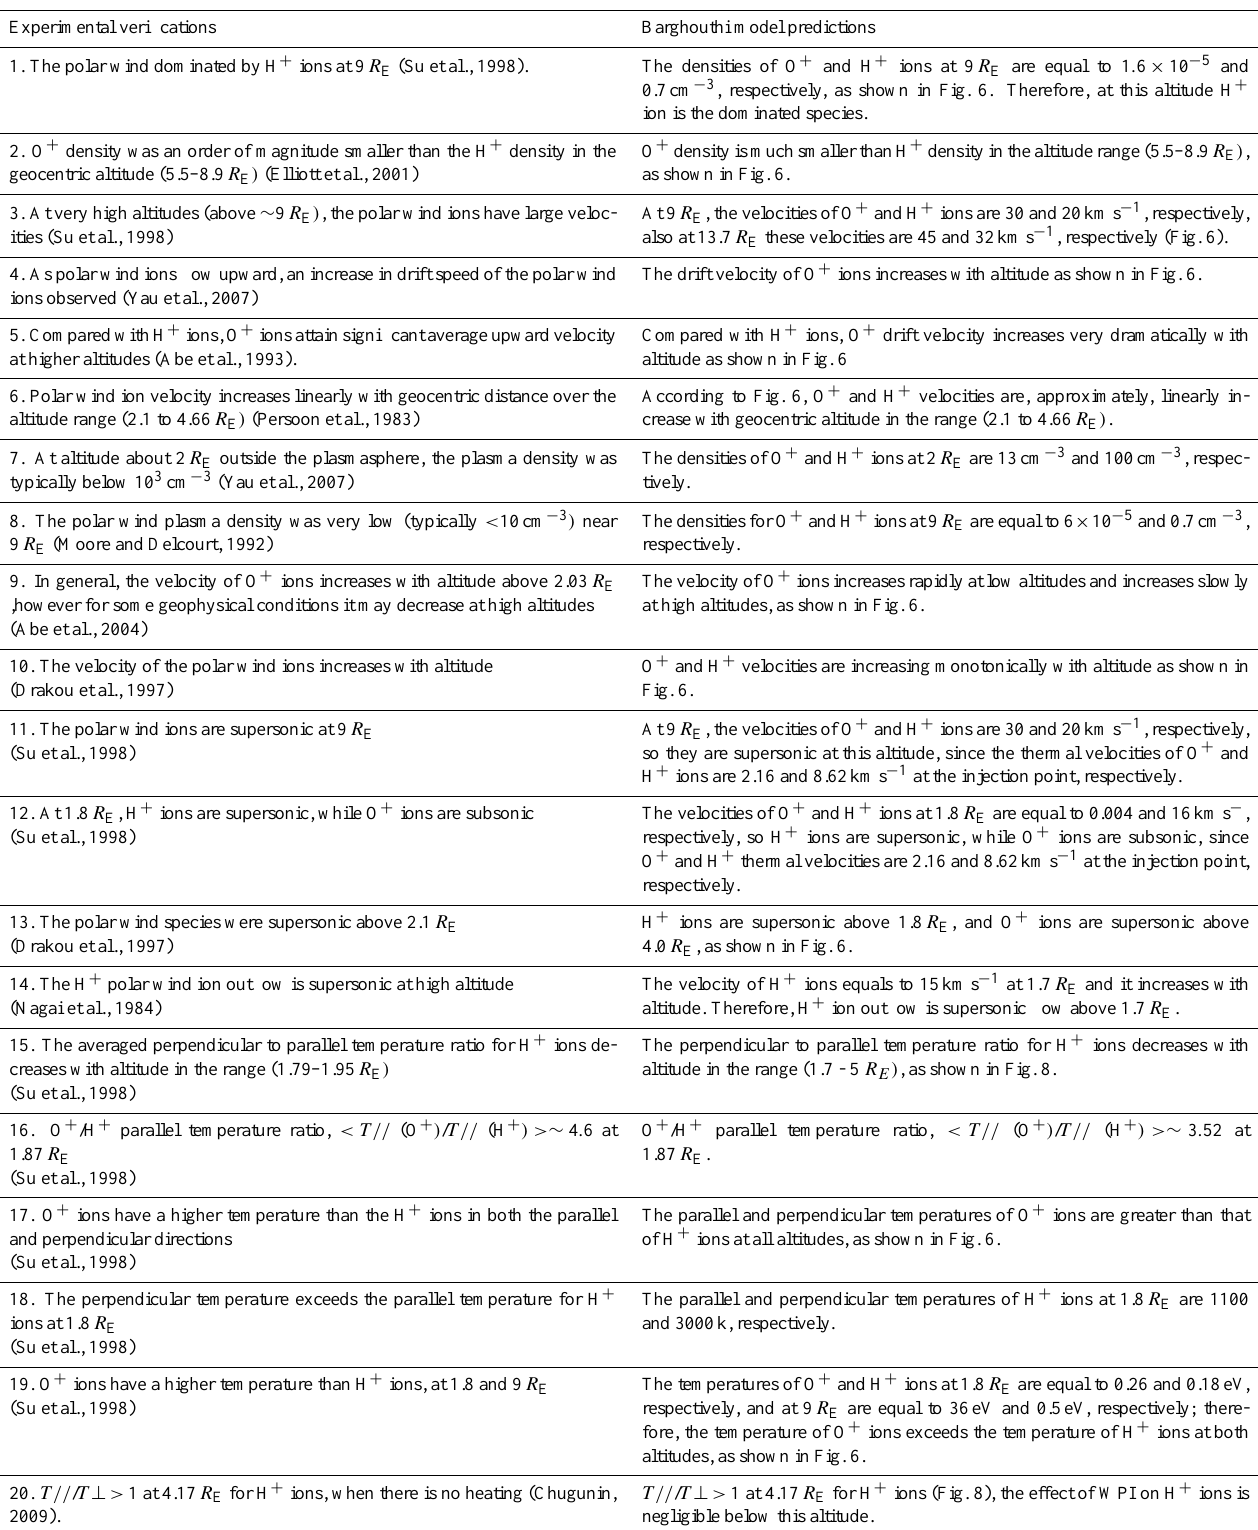
Table 3. Comparison between Barghouthi model predictions and experimental verifications. Please note, in observational studies they use the terms velocity, parallel velocity, and drift velocity. All these terms are the same in observational studies and correspond to drift velocity in simulation